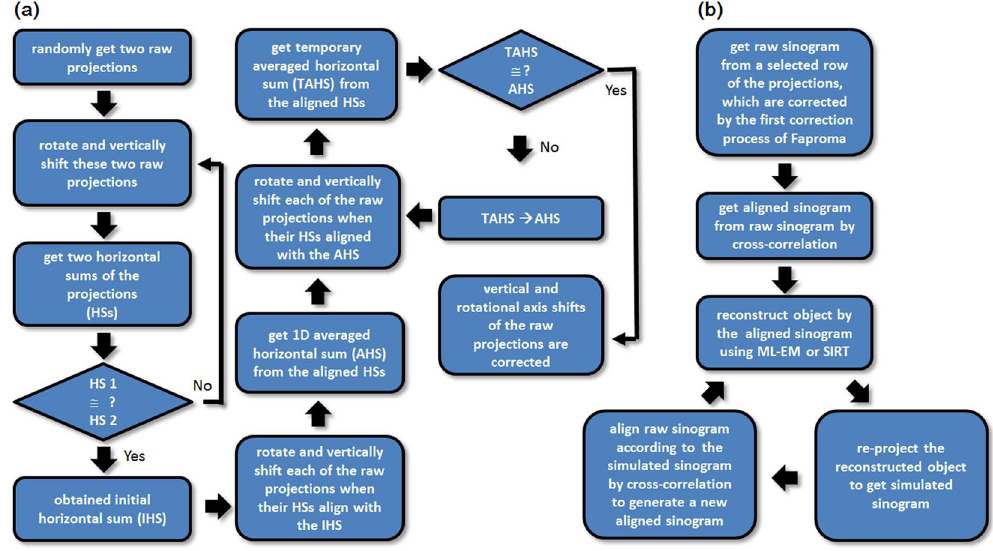
Figure 1. Flowchart of Faproma. ( a ) First correction process, which corrects vertical shift and rotational axis tilt simultaneously. ( b ) Second correction process, which corrects horizontal